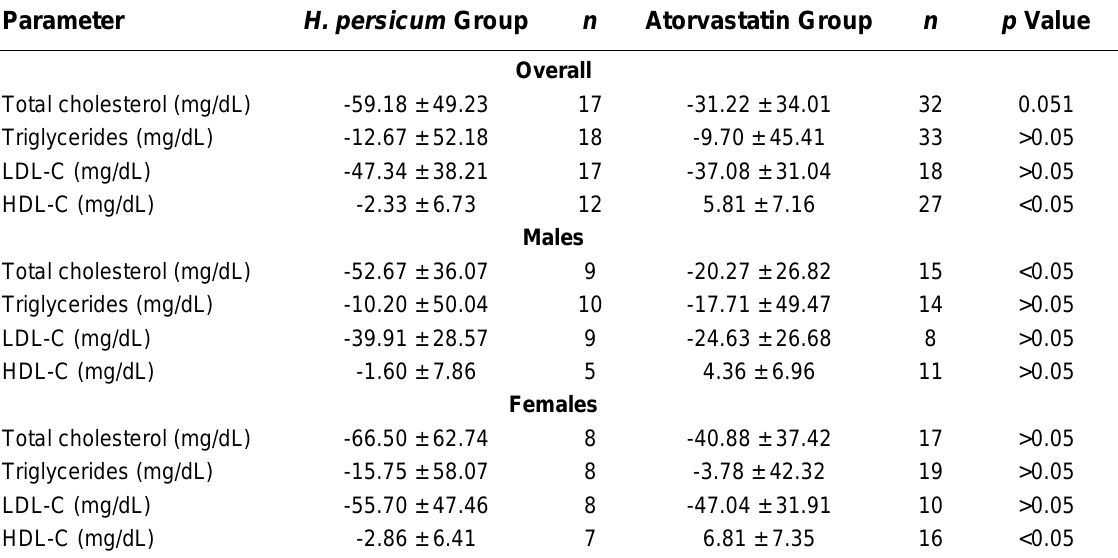
Magnitude of Change in Lipid Profile Parameters of H. persicum and Atorvastatin